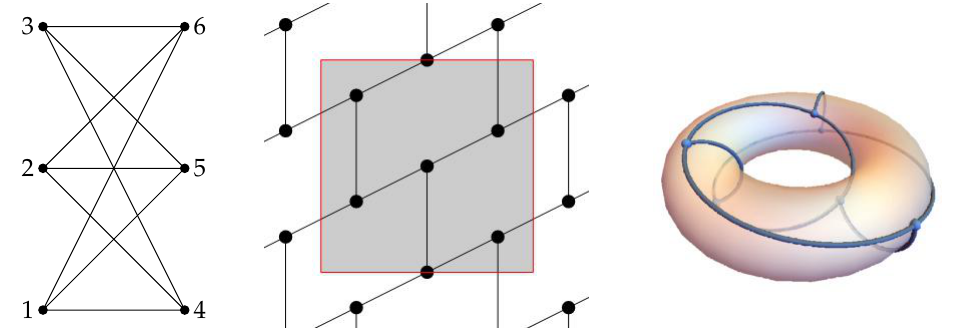
Figure 6. The drawings of K 3,3